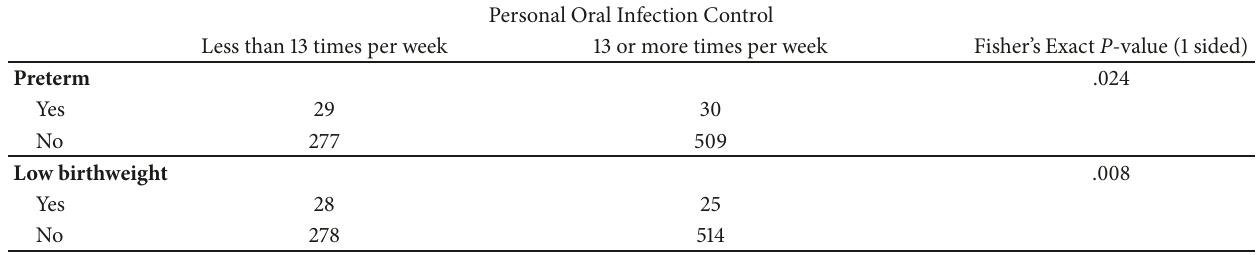
Table 2: Low birthweight and preterm birth by personal oral infection control/week.